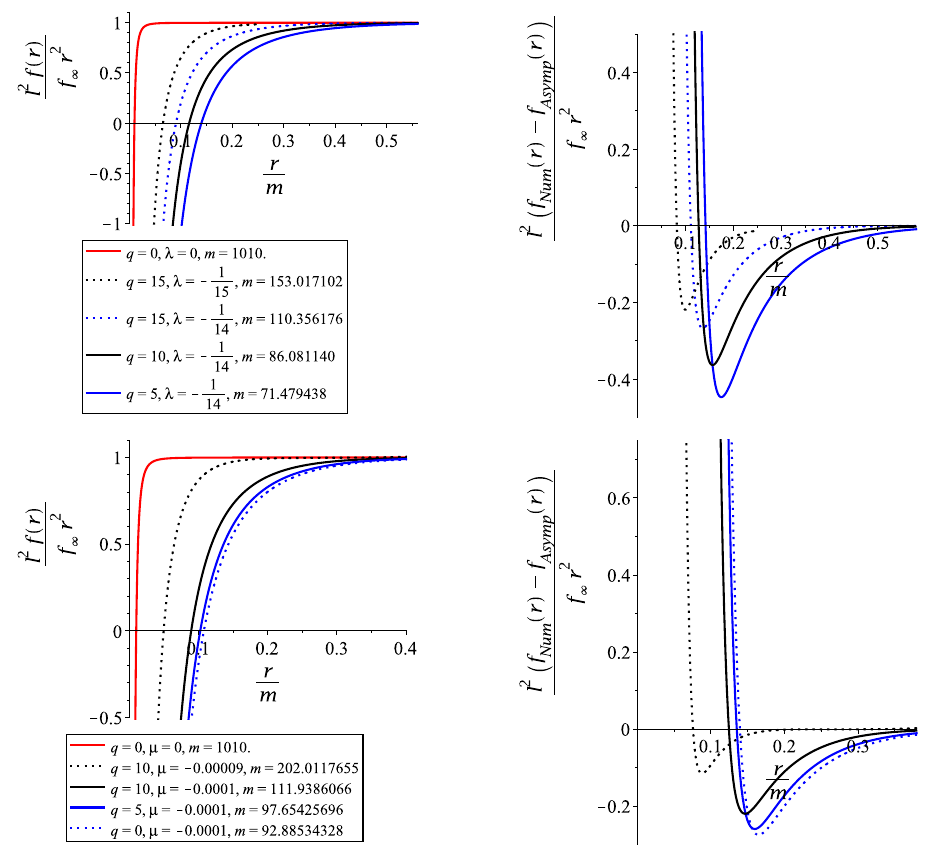
Figure 1 . Numerical solutions for cubic and quartic gravity (color online). Top left : the plot presents the rescaled metric function (2.32) in four dimensions for quartic gravity (with (cid:22) = 0). The red line shows the solution for Einstein gravity (for which the quartic coupling (cid:21) = 0) with zero electric charge. For the other curves we choose di(cid:11)erent values for these parameters. Top right : this panel depicts the di(cid:11)erence between the numerical solution and its corresponding large- r analytic solution in quartic gravity | we see that convergence holds asymptotically. Bottom left : the plot presents the rescaled metric function (2.32) in four dimensions for cubic gravity (with (cid:21) = 0); the red line is again the solution for Einstein gravity with zero charge. Bottom right : the di(cid:11)erence between the numerical solution and its corresponding large- r analytic solution in cubic gravity; we see again the asymptotic convergence. In all cases, we set ‘ = 1 and r + = 10. The mass parameter m is de(cid:12)ned in